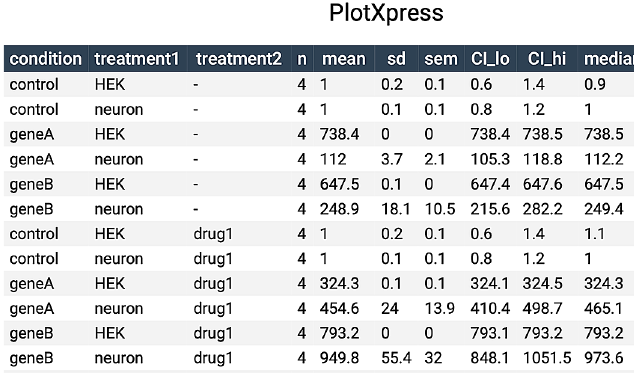
Figure 5. Data summary table. Table containing summary statistics of the data shown in Figure